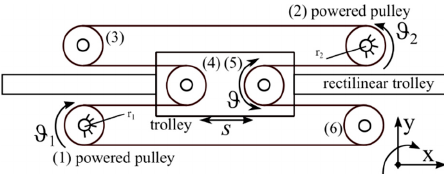
Figure 1. Kinematic scheme of the device: the transmission of the motion is realized thanks to a belt-based differential mechanism. Among the six pulleys of the mechanism, two are powered (pulleys (1) and (2) of the figure).